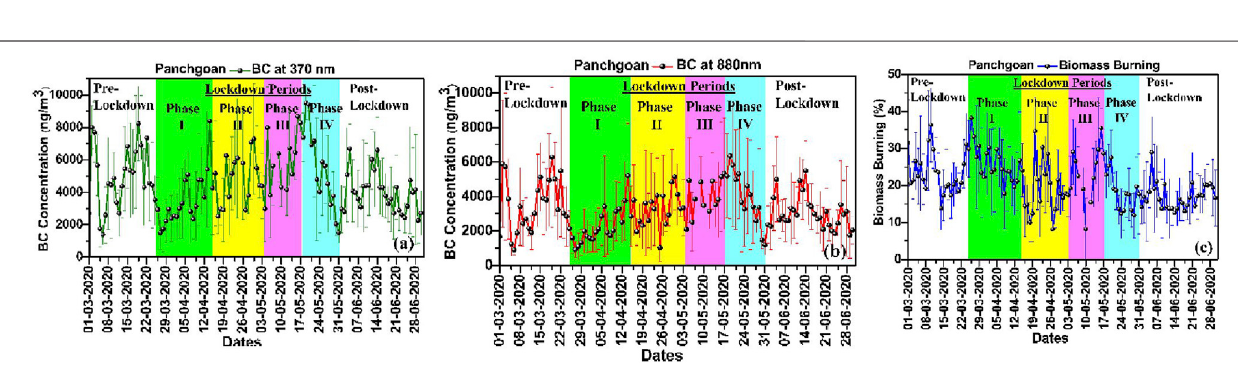
FIGURE6| Day-to-daymarchingofBCmassconcentrationandBB%obtainedusingmulti-spectralaethalometermeasurements (A) at370 nm, (B) 880 nm,and (C) BB%.